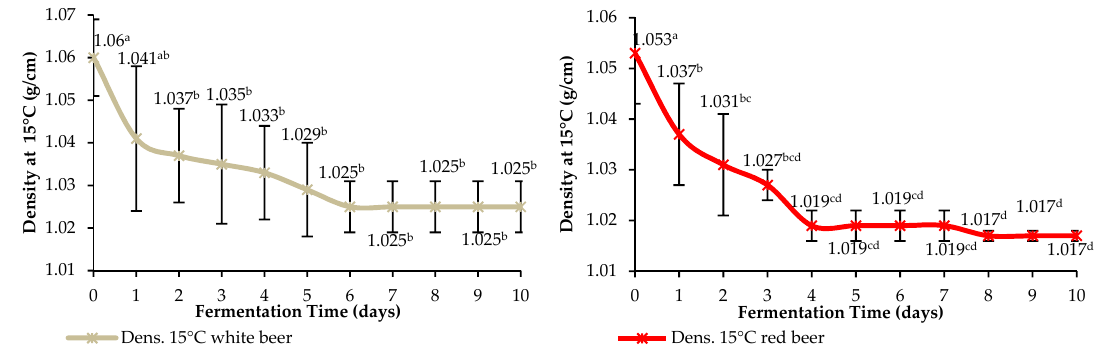
Figure 4. Evolution of density during fermentation of the indigenous sorghum beers. Mean values ( n = 3 repetitions) preceded by at least one common letter (a, b, c, d) were not significantly different ( p < 0.05). Bars represent standard deviations.